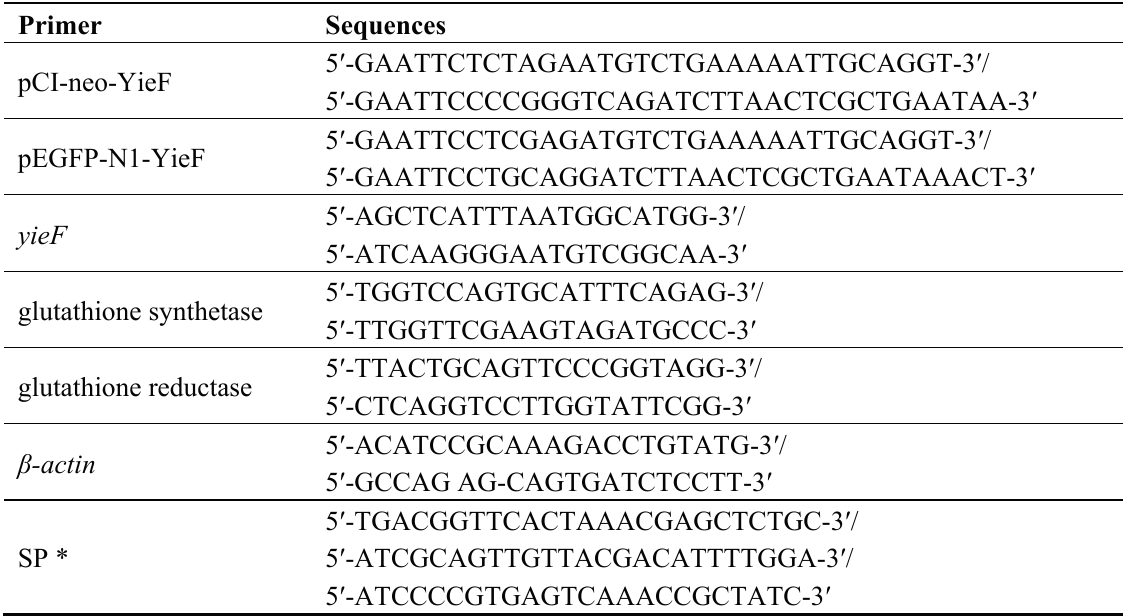
Table 1. Primers used in this